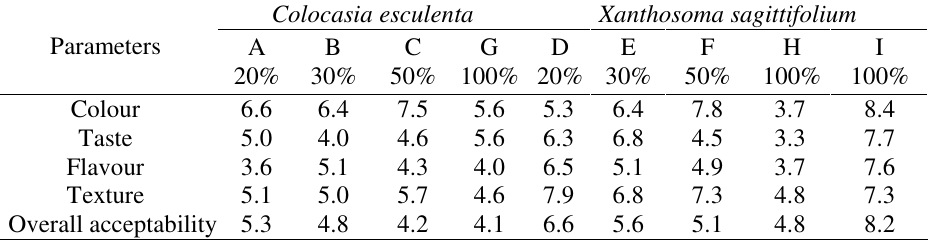
Table 6. Sensory evaluation of bread loaves